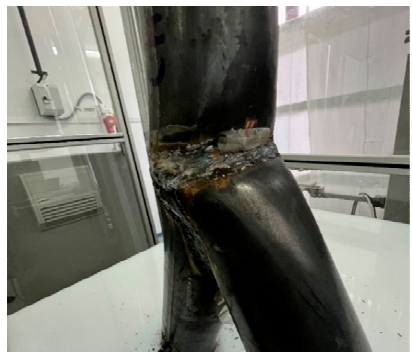
Figure 4. Deformation shape of the “CHS t = 2.0 mm” joint.